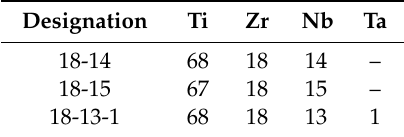
Table 1. Chemical composition of the Ti-Zr alloys, in atom